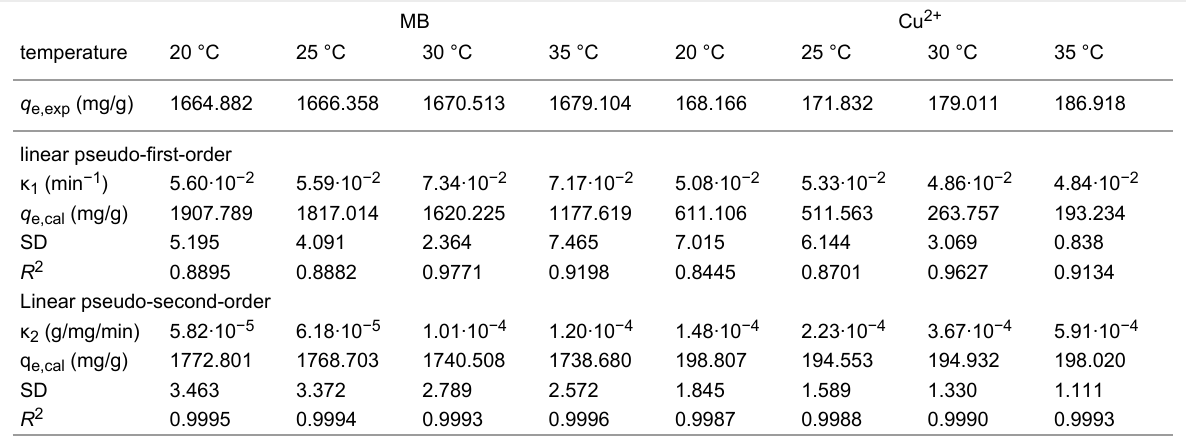
Table 1: The kinetic parameters for the adsorption of MB and Cu 2+ on Lys-GO a . MB Cu 2+ temperature 20 °C